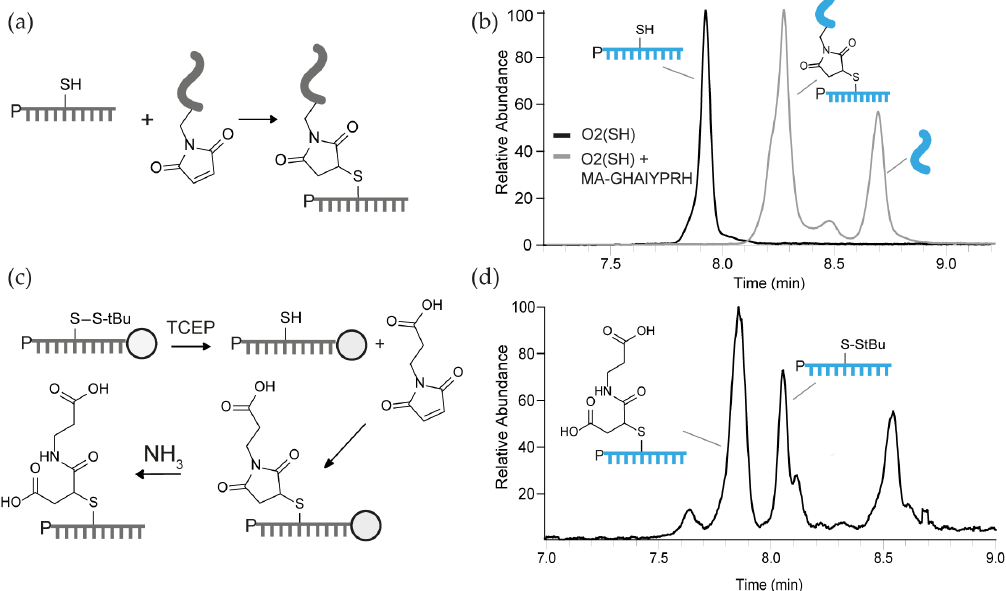
Figure 3. Thiol-maleimide conjugation in solution and on solid phase. ( a ) Reaction scheme for solution phase conjugation using 100 μ M oligonucleotide, 200 μ M TCEP, and 500 μ M peptide, 10% DMSO, overnight room temperature. ( b ) Overlayed LC-MS chromatogram of O2(SH) and the crude conjugation product showing full conversion to O2-GHAIYPRH conjugate. See Figure S4 for all conjugation reactions. ( c ) Reaction scheme for solid phase conjugation. TCEP treated CPG-bound oligonucleotide was reacted with 3-maleimidopropionic acid (10 mM in 50mM Tris, pH 7.2, 20% DMF) overnight, followed by cleavage using concentrated NH 3 , 24 h. Note that the reaction scheme shows only one possible hydrolysis product, see Figure S6 for an extended reaction scheme. ( d ) LCMS chromatogram of the crude product of solid phase conjugation reaction, after cleavage, see also Figure S6.